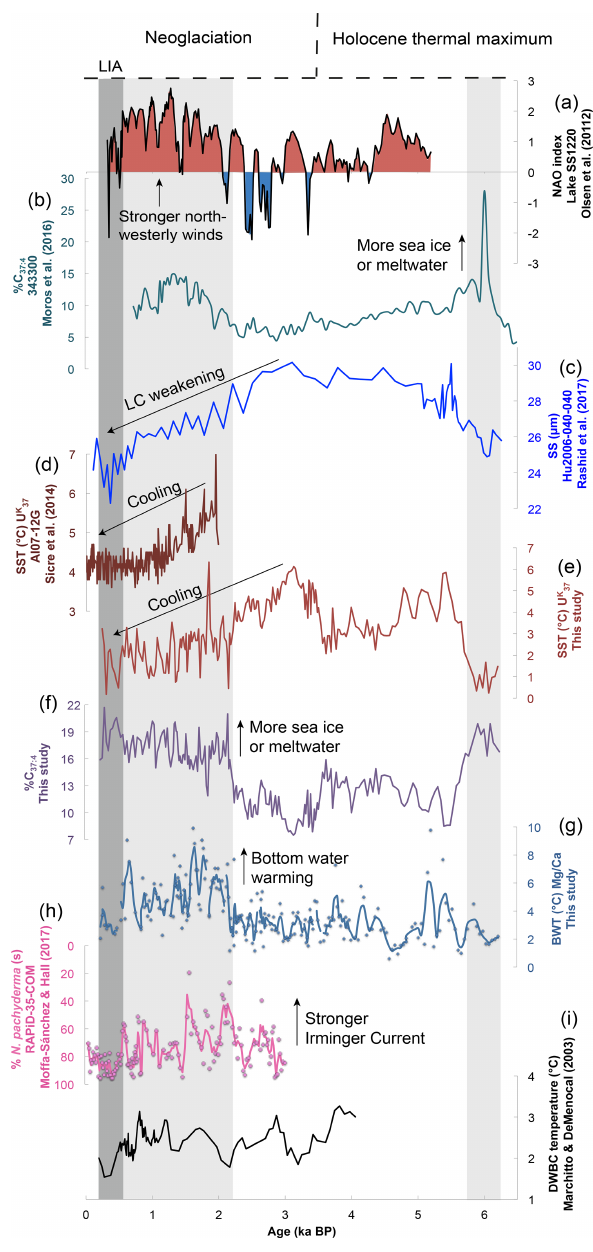
Figure 6. (a) The NAO index (Olsen et al., 2012) with positive (red) and negative (blue) phases. (b) %C 37 : 4 in core 343300 (Moros et al., 2016). (c) Sortable silt mean (µm) in core Hu2006-040-040 (Rashid et al., 2017). (d) SST record in Newfoundland core AI07- 12G (Sicre et al., 2014). (e) SST record based on the U K (this study). (f) Higher levels of %C 37 : 4 are interpreted as reflecting a longer sea ice season or meltwater. (g) BWT estimates are based on Mg / Ca ratios in benthic foraminifera N. labradorica and reflect subsurface conditions. (h) Lower abundances of polar water plank- tic foraminifera species N. pachyderma sinistral in central Labrador Sea core RAPiD-35-COM indicate warming due to stronger IC in- flow (Moffa-Sánchez and Hall, 2017). (i) Mg / Ca temperature esti- mates representing the Deep Western Boundary Current (Marchitto and deMenocal, 2003). Grey vertical bars highlight periods of pro- nounced oceanographic